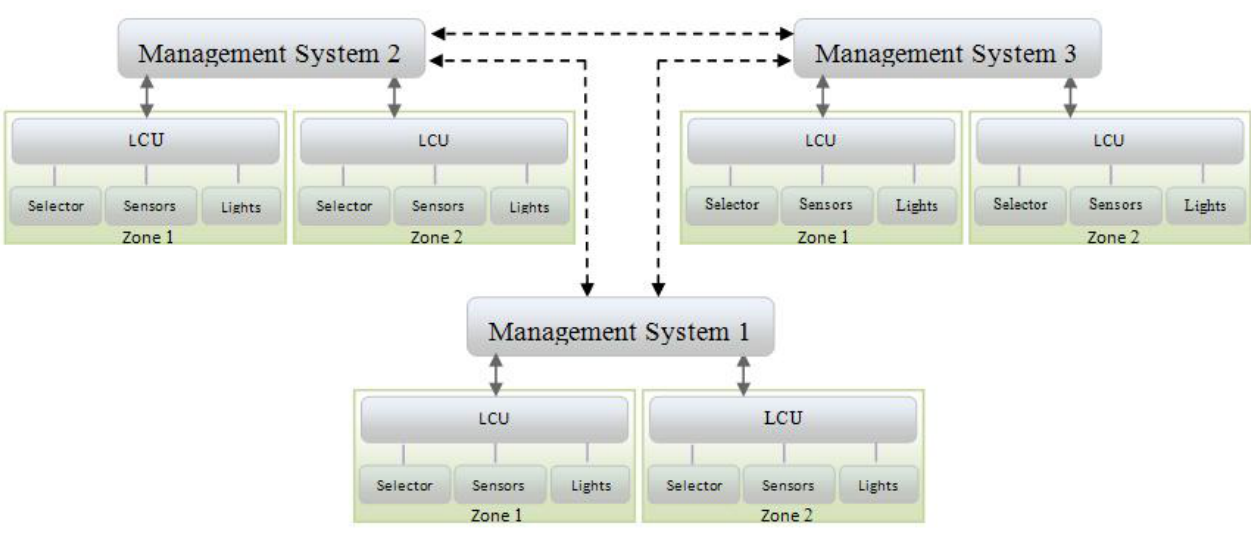
Figure 2. Distributed Lighting Automatic Control